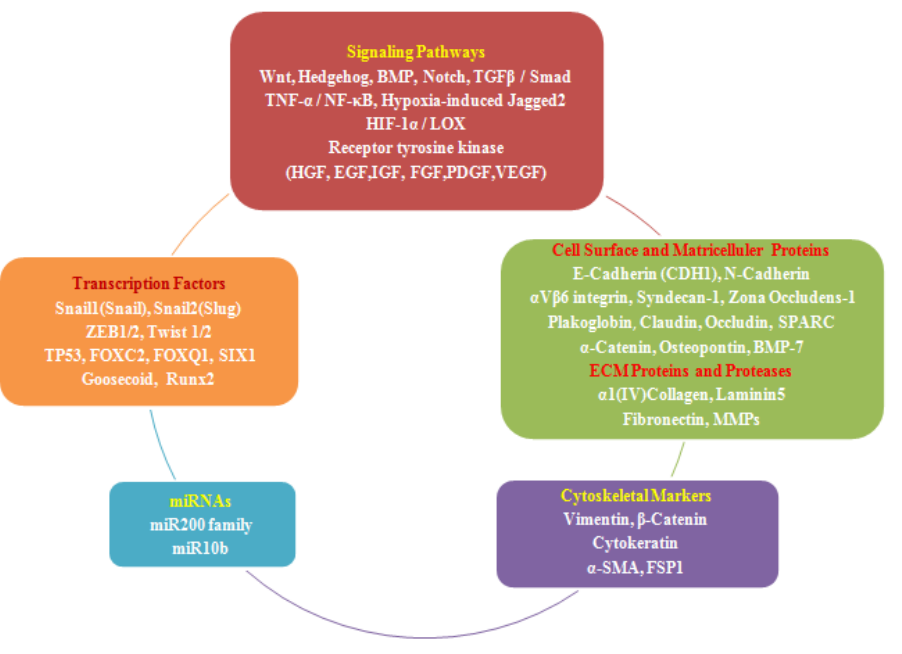
Figure 1. Signaling pathways and markers of epithelial to mesenchymal transition